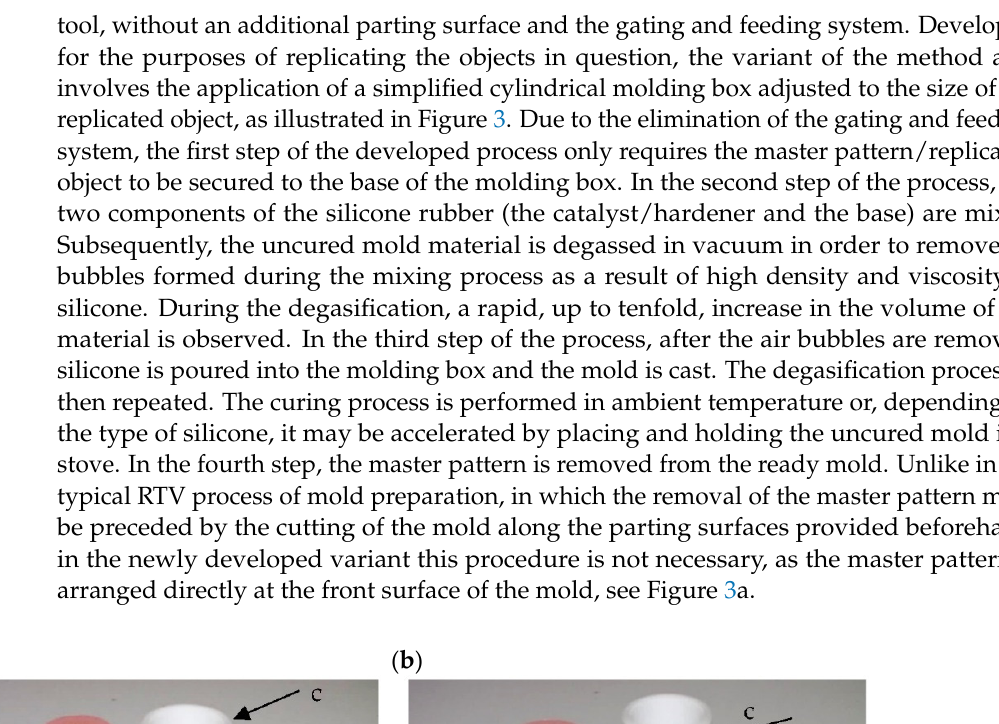
4 of 14 Figure 2. Mark left by the removed gating channel on the surface of the replica (indicated in red) and casting defects (indicated in yellow).